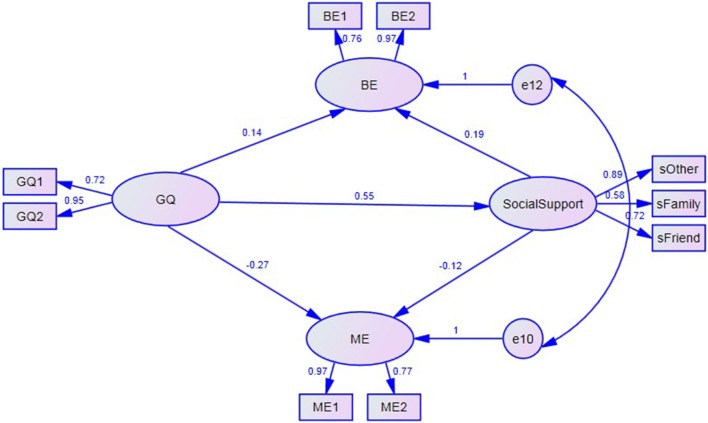
The mediation model. Factor loadings are standardized. BE1 and BE2 are two parcels of benign envy; ME1 and ME2 are two parcels of malicious envy; GQ1 and GQ2 are two parcels gratitude; sOther, sFamily and sFriend are subscales of the Multi-Dimensional Scale of Perceived Social Support.